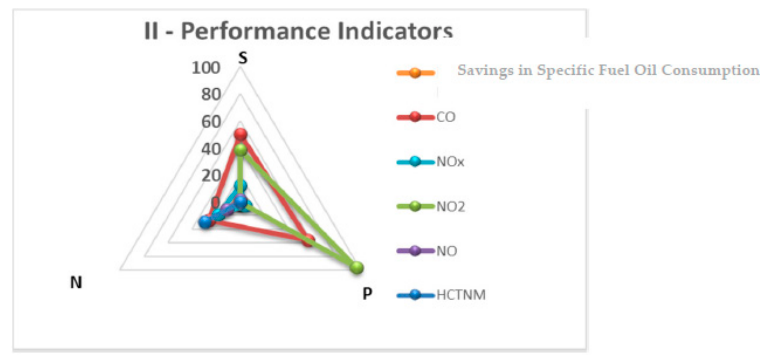
Figure 28. Indicators in process model II.